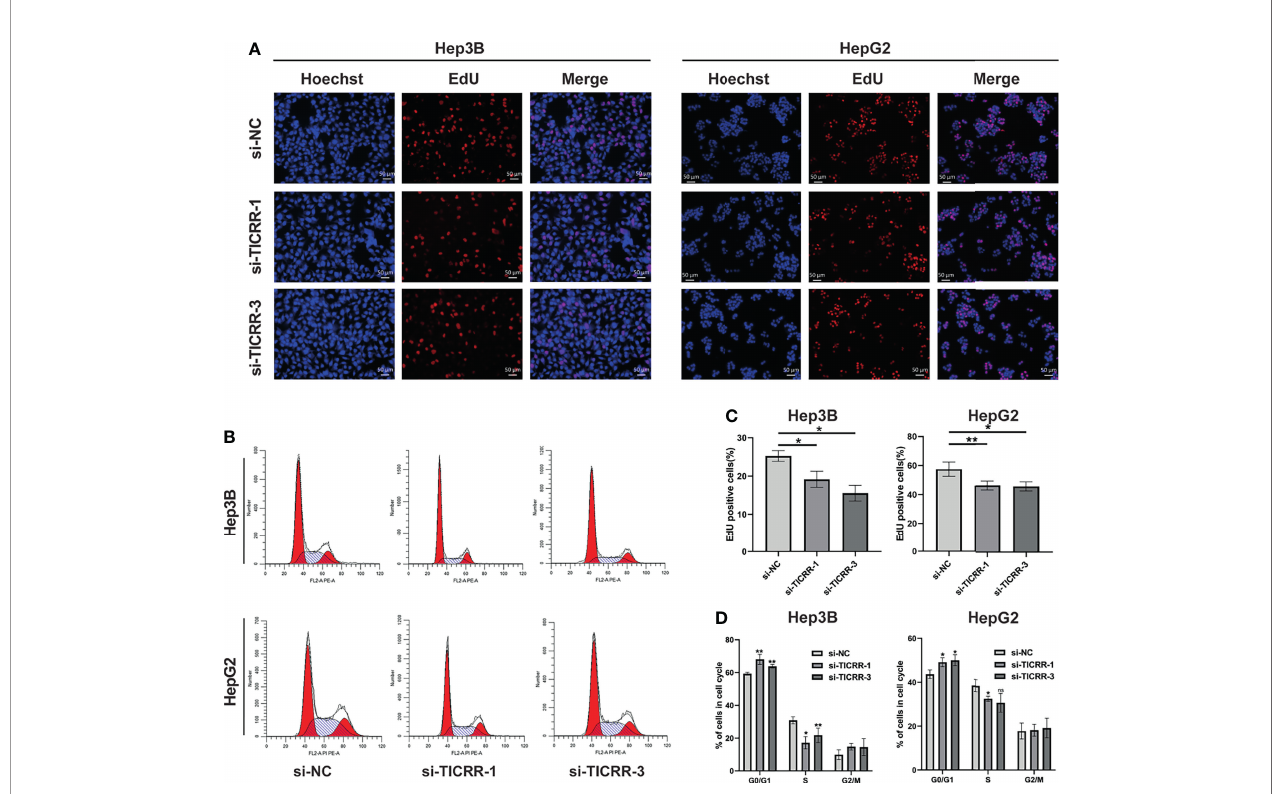
FIGURE 11 | Downregulation of TICRR attenuated proliferation by promoting G1/S arrest. (A, C) Knockdown of TICRR in Hep3B and HepG2 cells by both 2 separate TICRR siRNAs caused decreased proliferation, as measured by EdU assay. (B, D) Silencing TICRR restrained G1/S transition in Hep3B and HepG2 cells by